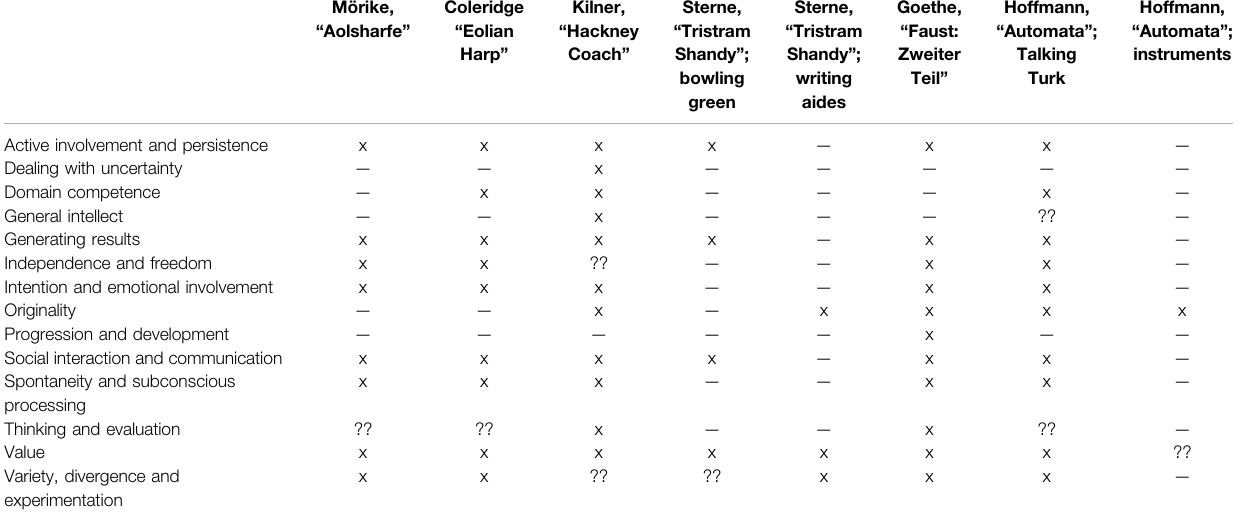
TABLE 4 | Analysis of works by creativity